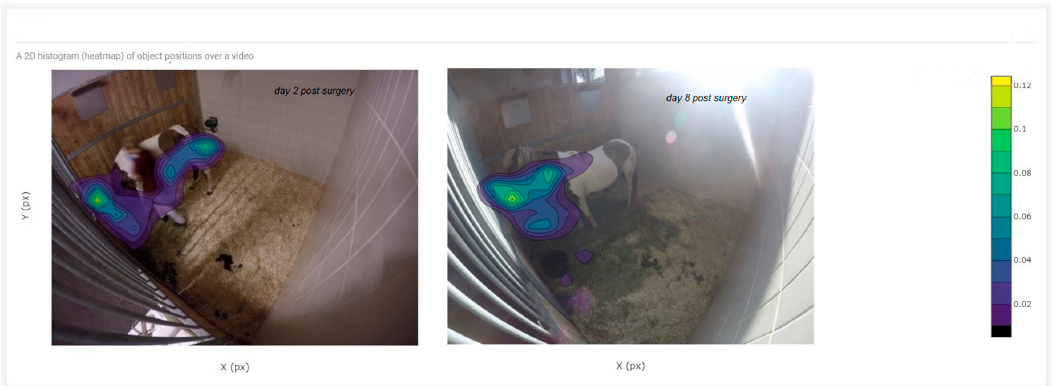
Figure 2. Heat map of the horse on day 2 and on day 8 post colic surgery. The horse spent 67% and 91% of the time in front of the box on days 2 and 8 respectively. Food was provided early in the morning and recording started at 06:30.